Question: Summarize what this figure shows in one sentence.
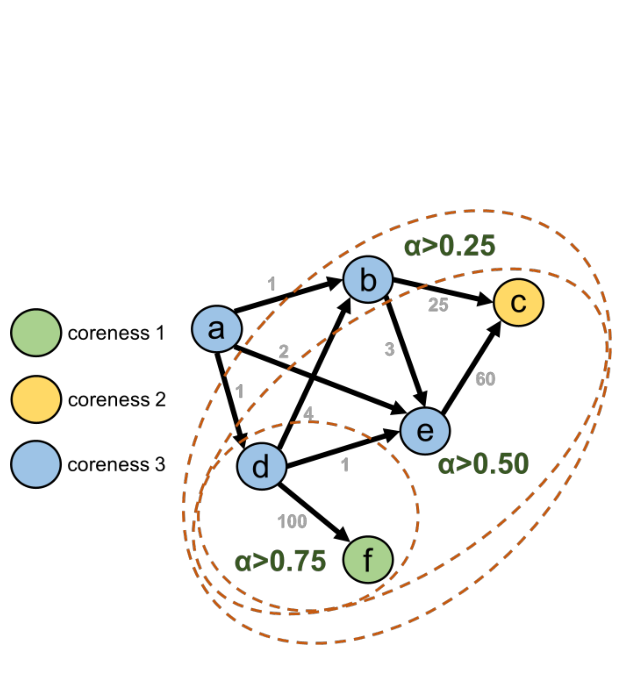
Answer: A running example to compare between the graph-𝑘-core and AlphaCore decomposition methods. The Coreness of nodes ac- cording to graph-𝑘-core decomposition is shown with different node colors, whereas AlphaCore is run with in-strength and out-strength as node features with a step size of 0.25. Different AlphaCores are shown using dotted boundaries.